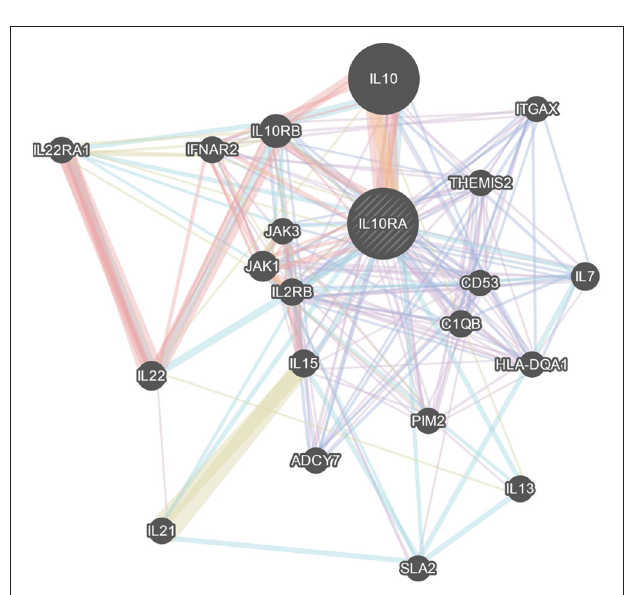
FIGURE 5 | Molecular surface docking view of selected mutant models. Mutant IL10RA-Y91C (Yellow in color) with IL10 (Blue in color); and mutant IL10RA-R101W (Green in color) with IL10 (Blue in color); Based on Highest to lowest difference in binding energies compared with wildtype docking